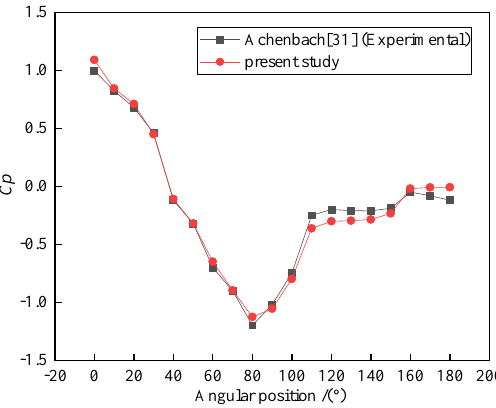
Figure 3. Comparison of pressure coefficients between literature and the present study.